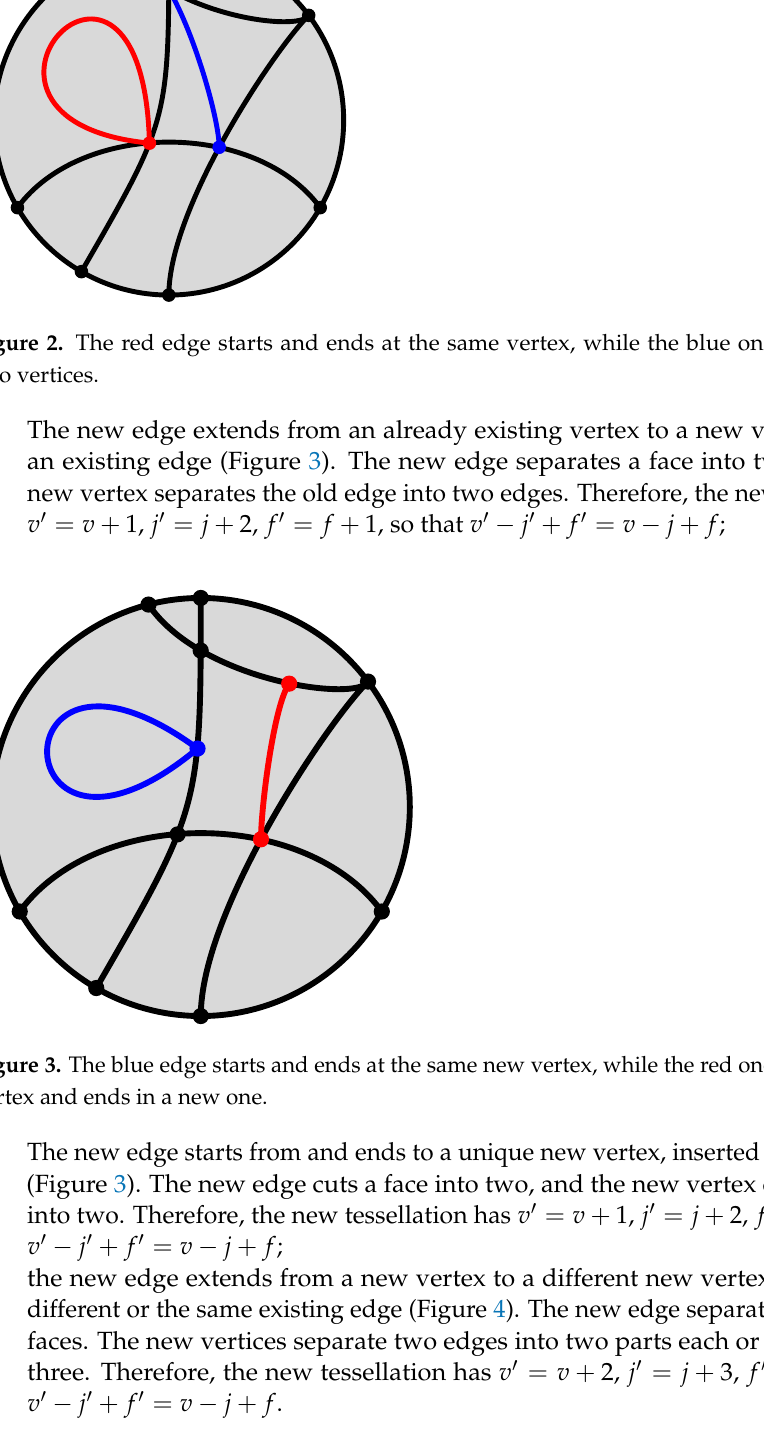
Figure 4. The red edge lies between two different new vertices on the same edge, while the blue one lies between two new vertices belonging on two different edges.